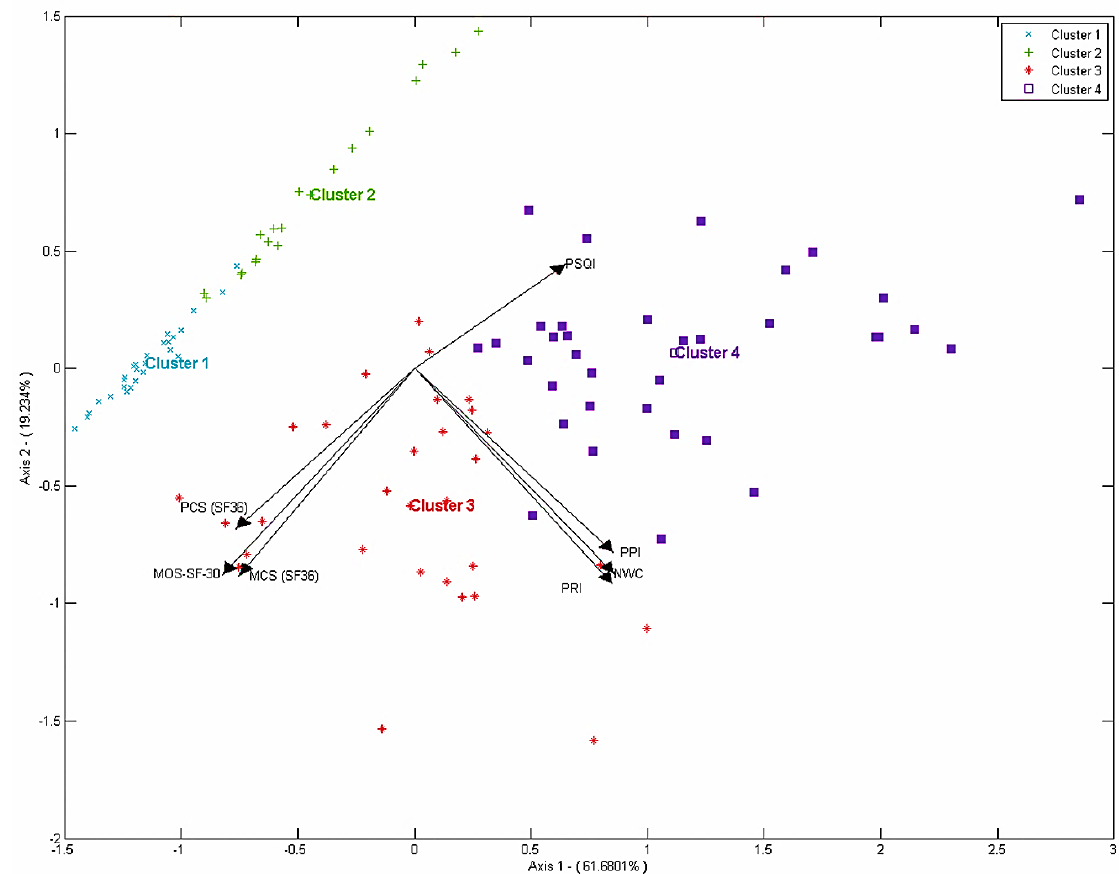
Figure 1. Representation biplot of the questionnaires applied per variable and patient. MCS, mental component summary score; MOS-SF-30, Medical Outcomes Study Short Form Survey 30; MPQ, McGill Pain Questionnaire; NWC, number of words chosen; PCS, physical component summary score; PPI, present pain intensity; PRI, pain rating index; PSQI, Pittsburgh Sleep Quality Index; SF-36, Short Form 36 Health Survey.